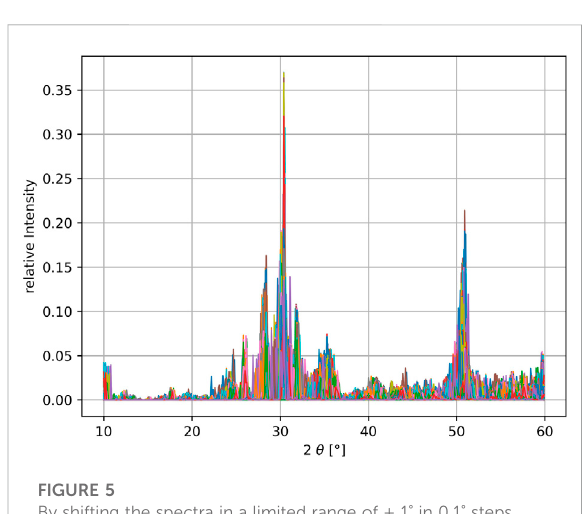
FIGURE 5 By shifting the spectra in a limited range of ± 1 ° in 0.1 ° steps and optimizing the overall overlap, the spectra are standardized to fi t better into crystal